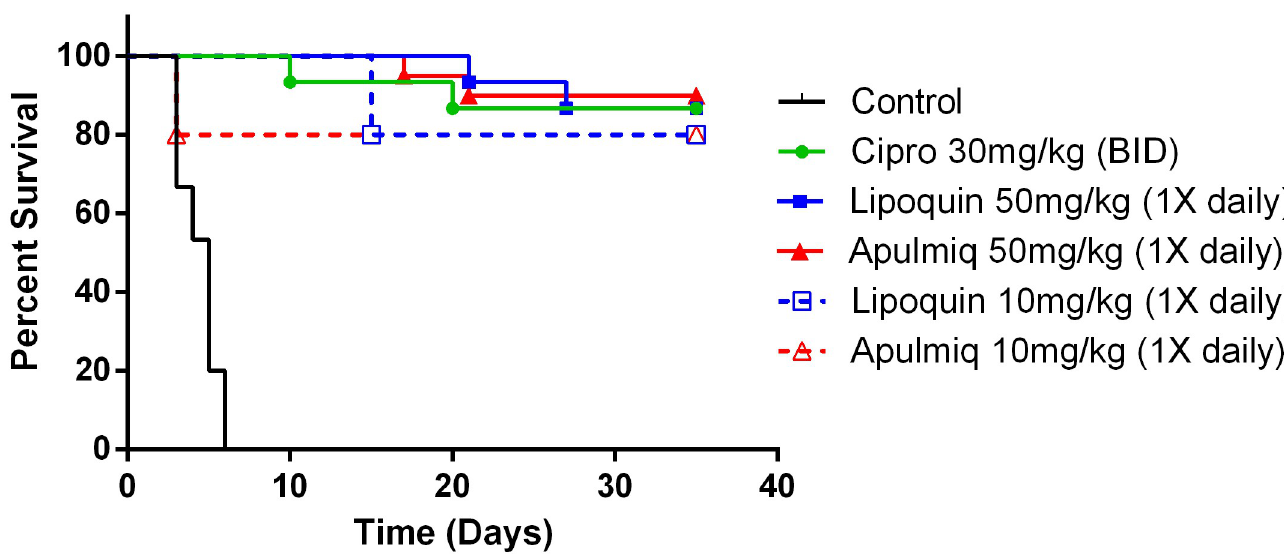
Fig 1. The efficacy of ciprofloxacin, lipoquin and apulmiq was evaluated in a post-exposure prophylaxis model after a lethal B . anthracis Ames challenge. Balb/c mice were challenged with 10 LD 50 of B . anthracis Ames, and were treated as described, 24 hours after exposure for seven days. Therapeutic efficacy of intranasal delivered apulmiq and lipoquin (once daily) was compared at 50 mg/kg and 10 mg/kg versus intraperitoneal delivered ciprofloxacin (b.i.d.) and PBS- treated control mice. Graphs show the survival of mice following 7 days of therapy. All treatments improved survival compared to PBS (P < 0.001). There was no significant difference between the two concentrations of lipoquin and apulmiq